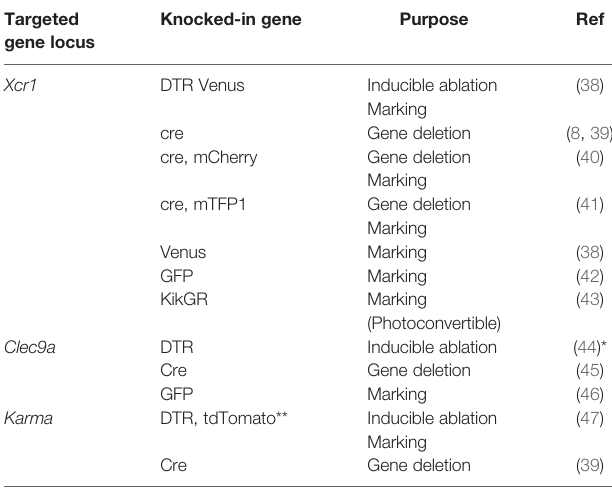
TABLE 1 | Knock-in mice for analyzing XCR1+